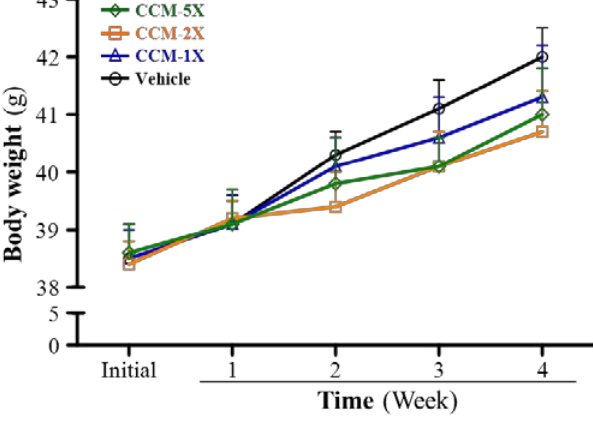
Figure 7. The effect of CCM supplementation on growth. Data are mean ± SEM for n = 10 mice per